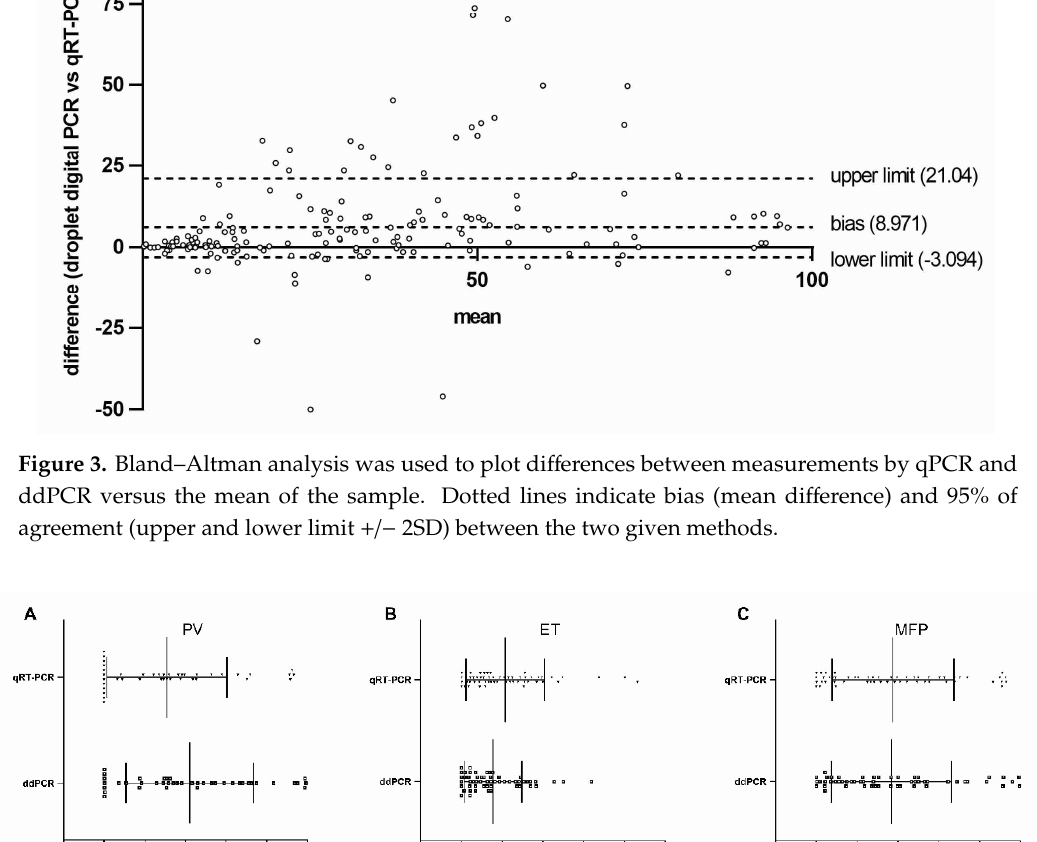
Figure 4. Comparison of median JAK2 V617F allele burden measured by qPCR and ddPCR. The